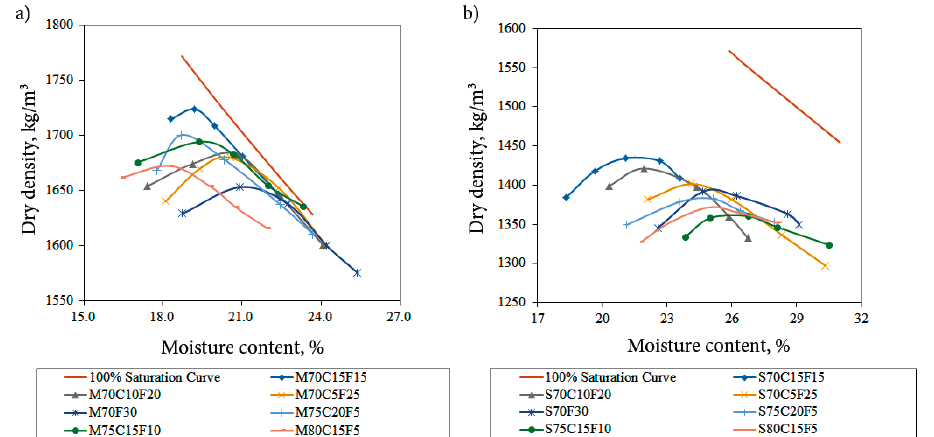
Fig. 2. Compaction curves of (a) S/S treated marine mud and (b) S/S treated